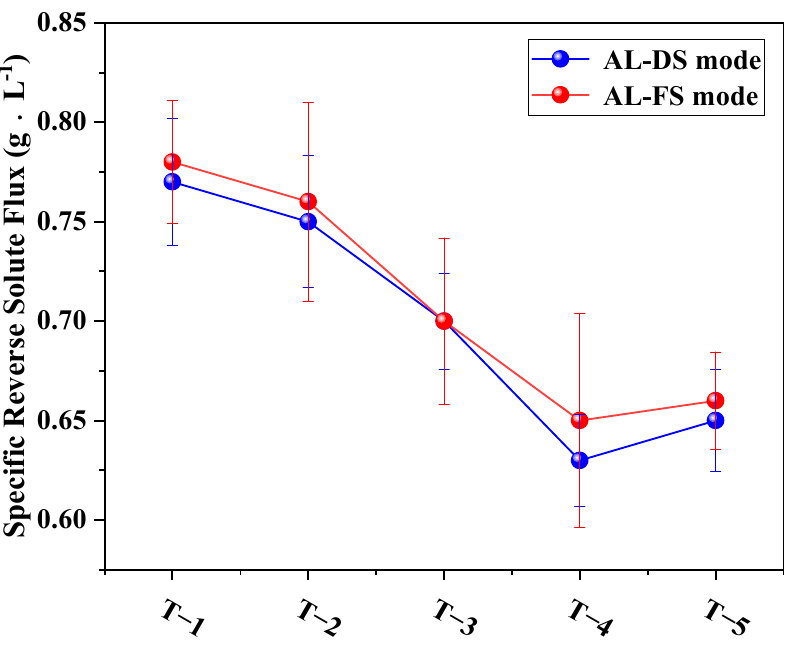
Figure 13. The effects of different amounts of MXene nano-sheets on the specific reverse solute flux of the TFC-FO membranes.